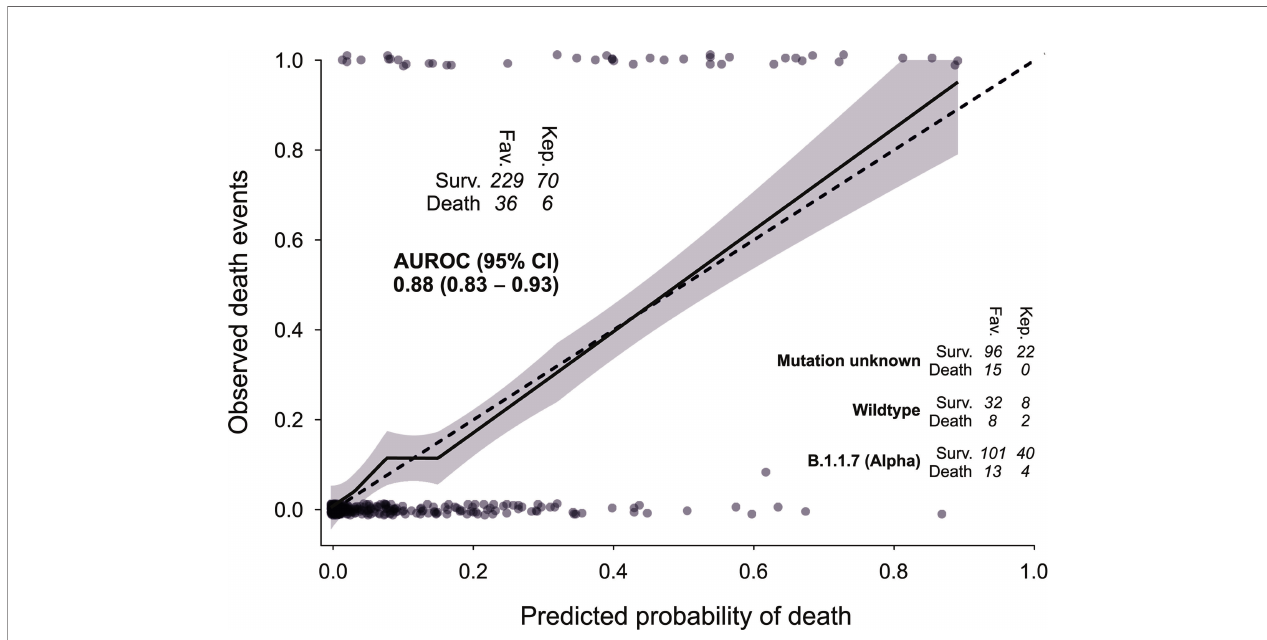
FIGURE 3 | Model performance. Discrimination and calibration in another cohort admitted to hospital while the B.1.1.7/Alpha variant of SARS CoV-2 was widespread. Fav., Clinic Favoriten; Kep., Kepler University